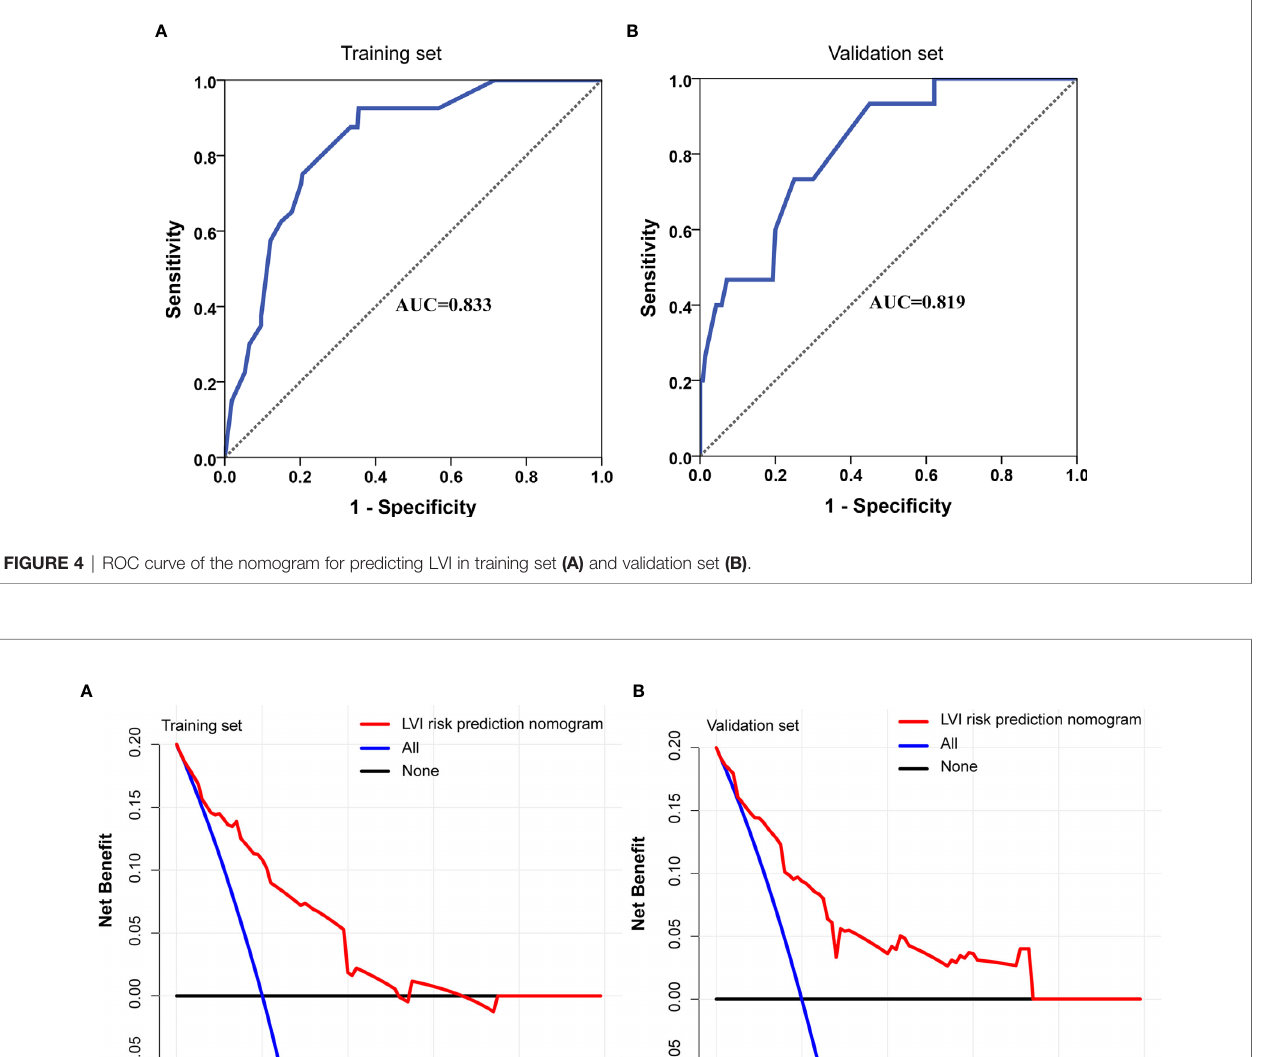
FIGURE 5 | Decision curves of the nomogram predicting LVI in training set (A) and validation set (B)